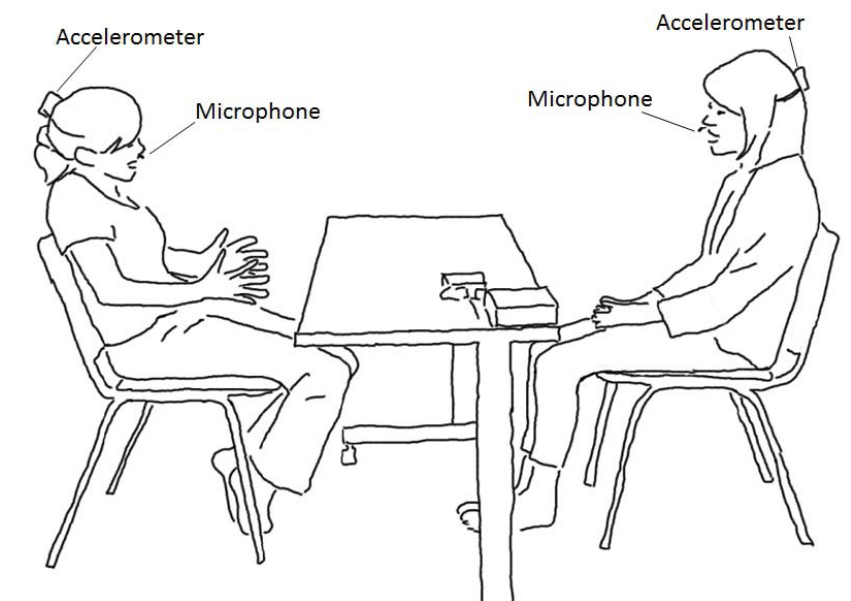
Figure 1. Illustration of setup for recording the dialogue. The client sits on the left and the therapist sits on the right with a table between